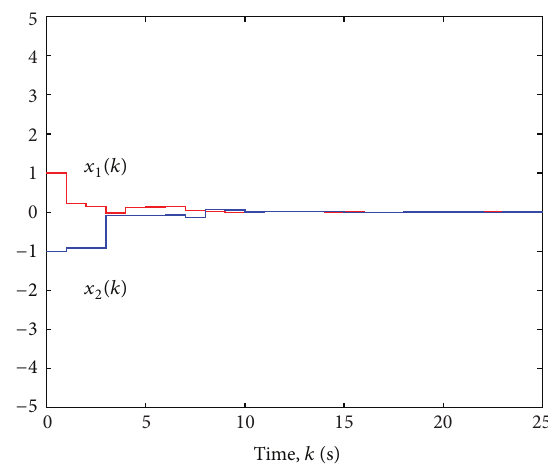
Figure 5: State responses of the switched systems